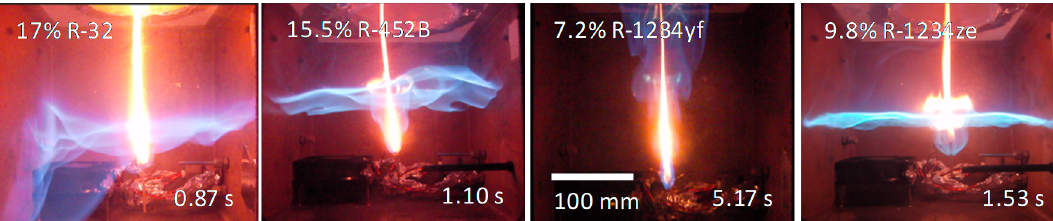
Figure 3. Images from safety match tests corresponding to the largest flame for each test. The times shown are elapsed times after the onset of flaming. A video of these tests is provided in the Supplementary Materials Video S3.